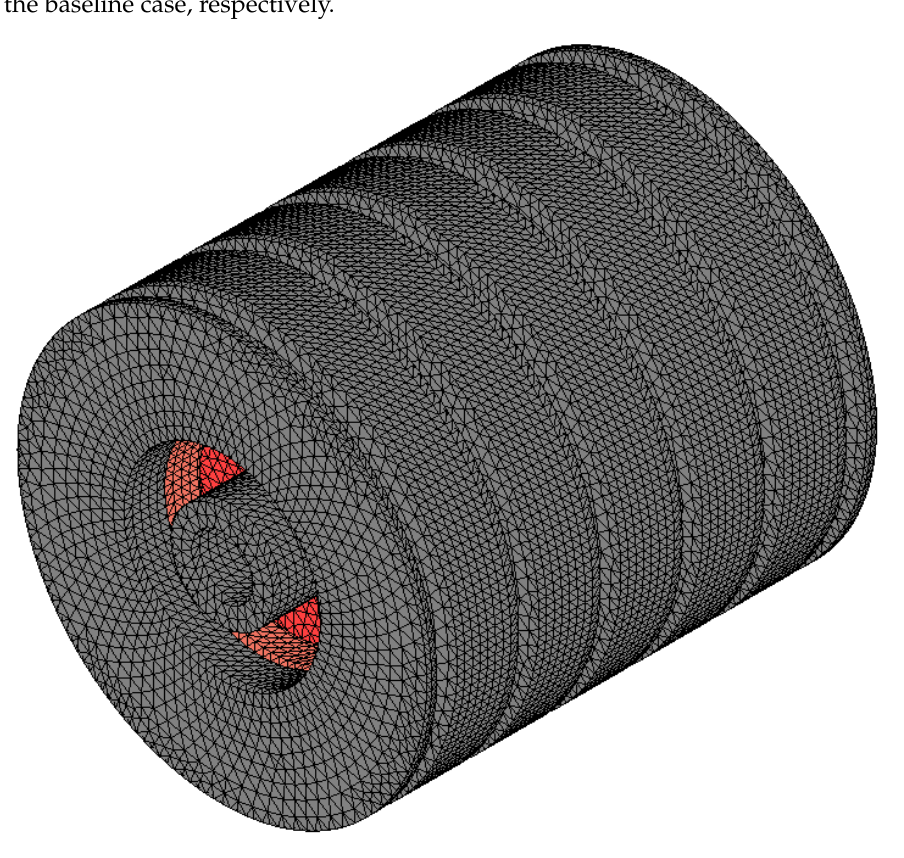
Figure 2. Mesh distribution in the transient analysis.